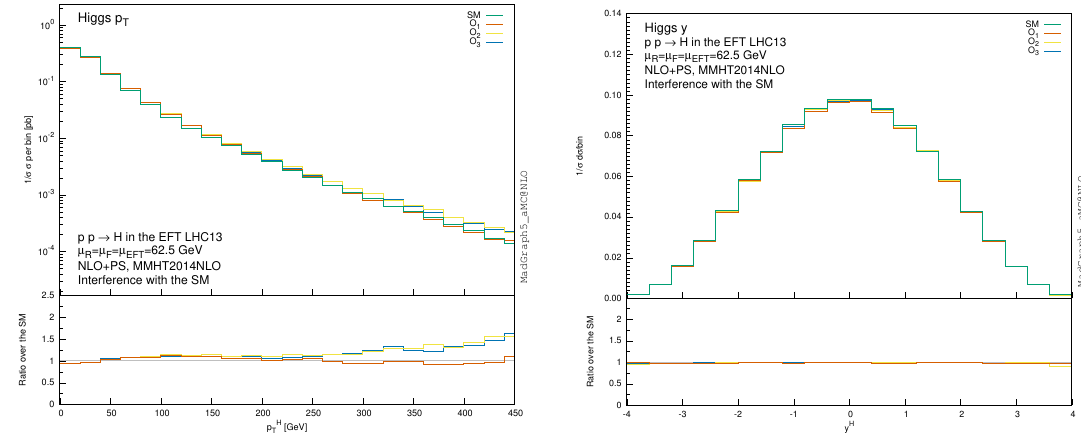
Figure 4 . Higgs distributions, normalised for the interference contributions from (cid:27) i . Left: Higgs transverse momentum. Right: Higgs rapidity. SM contributions and individual operator contribu- tions are displayed. Lower panels give the ratio over the